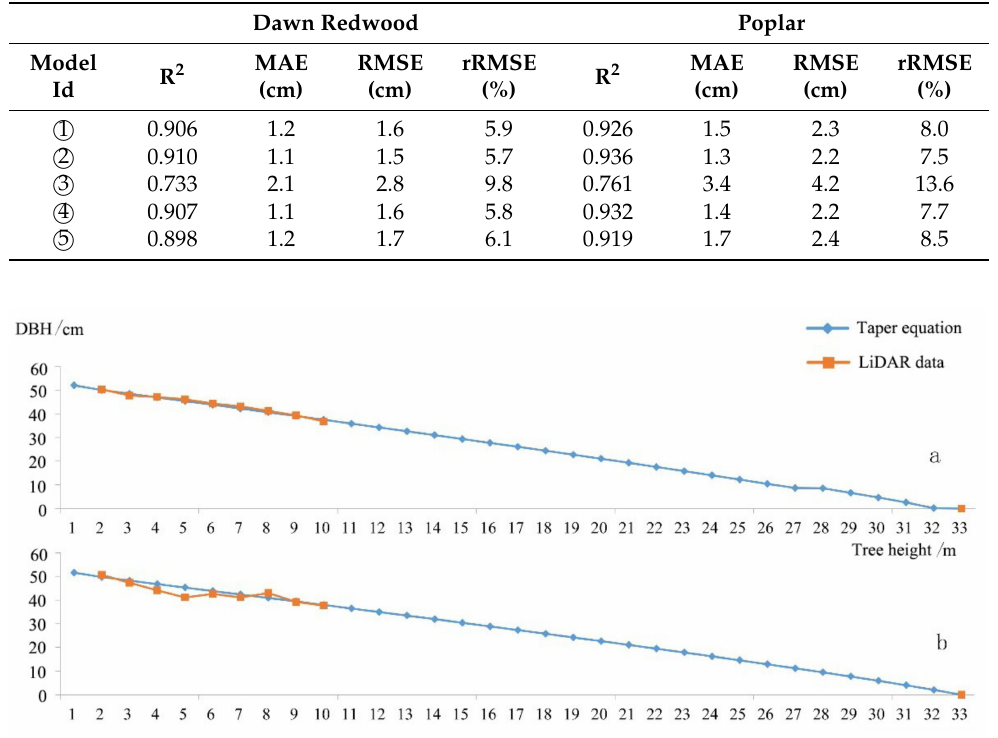
Figure 6. Comparison of the stem curves of dawn redwood and poplar acquired from taper model and LiDAR data. ( a ) Dawn redwood, ( b )